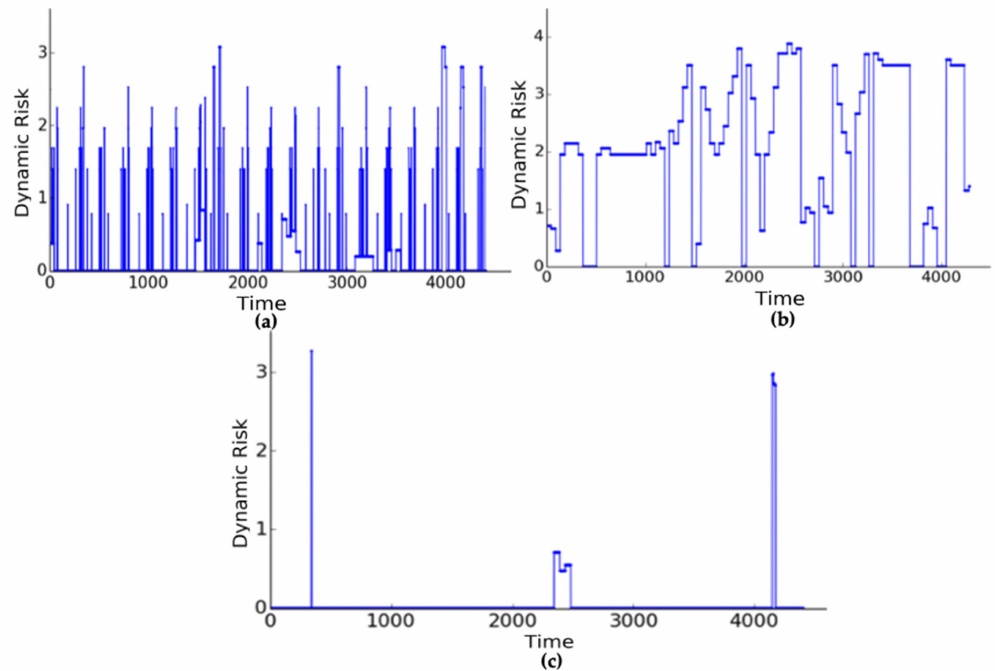
Figure 5. Experimental evaluation of dynamic risk evaluation filter condition thresholds: ( a ) per- operation-based (POT), ( b ) per-task-based (PTT), and ( c ) per-path-based (PPT) dynamic risk